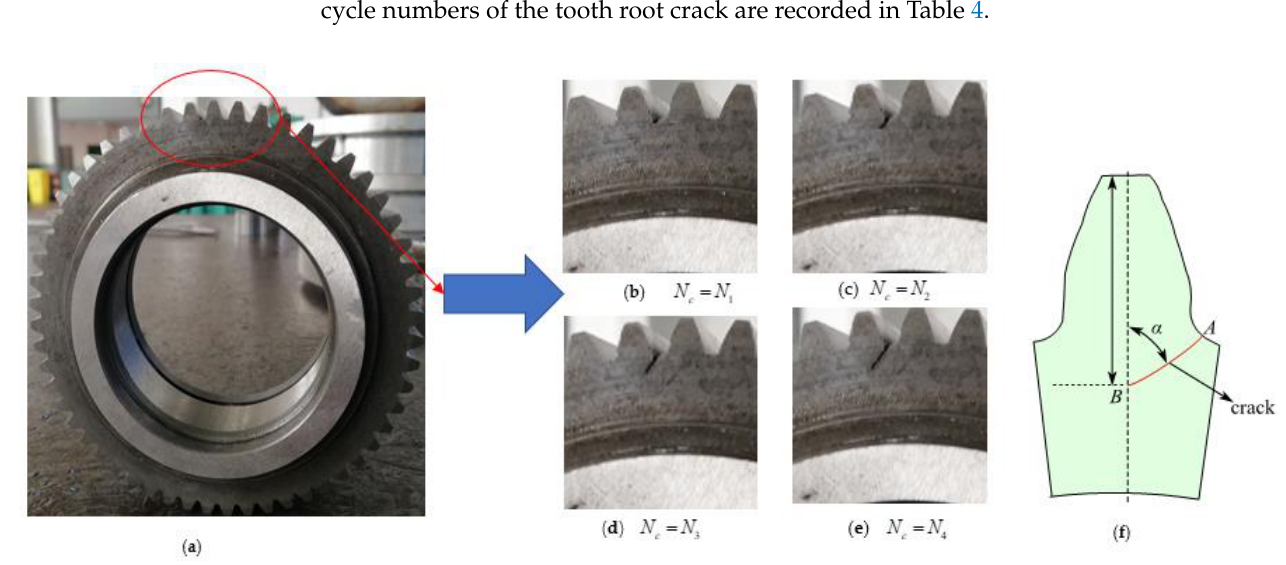
Figure 15. Marco tooth root fatigue crack of the test specimen. ( a ) driven gear sample; ( b ) crack propagates under cyclic index N c = N 1 ; ( c ) crack propagates under cyclic index N c = N 2 ; ( d ) crack propagates under cyclic index N c = N 3 ; ( e ) crack propagates under cyclic index N c = N 4 ; ( f ) crack propagates along the red lines.